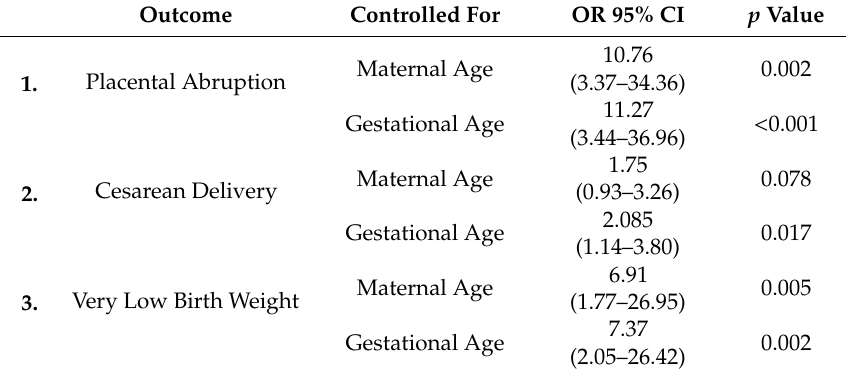
Table 4. Generalized estimation equation models for placental abruption, cesarean delivery, and very low birth weight, controlling for maternal age and gestational age.